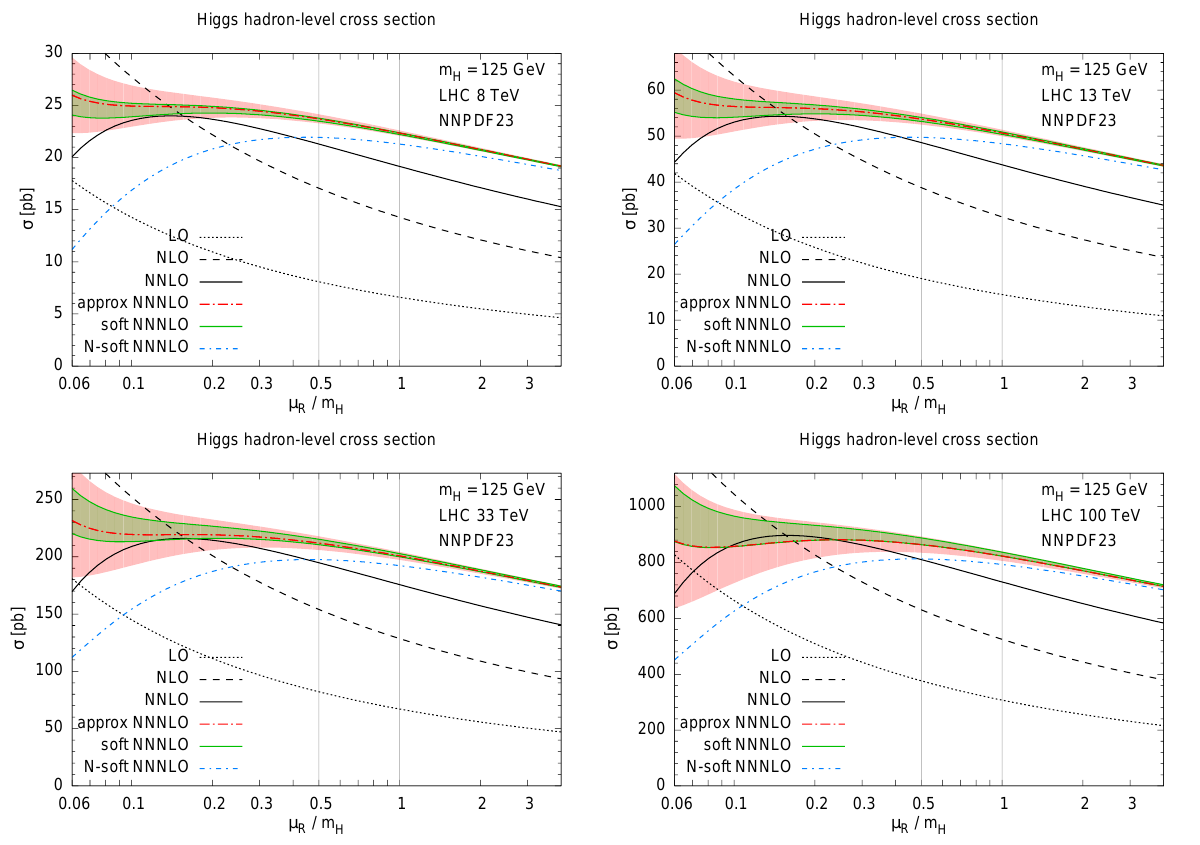
= m = 125 GeV and collider energy 8 TeV , for µ H R F